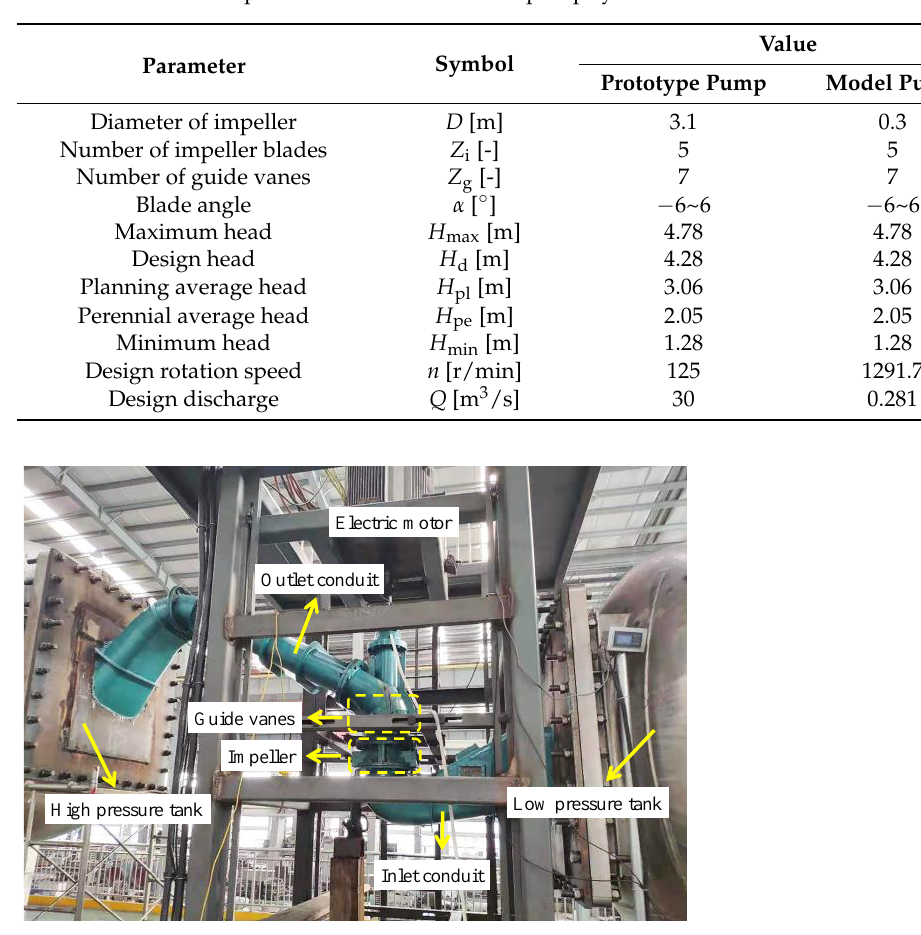
Table 1. Characteristic parameters of the axial flow pump system.